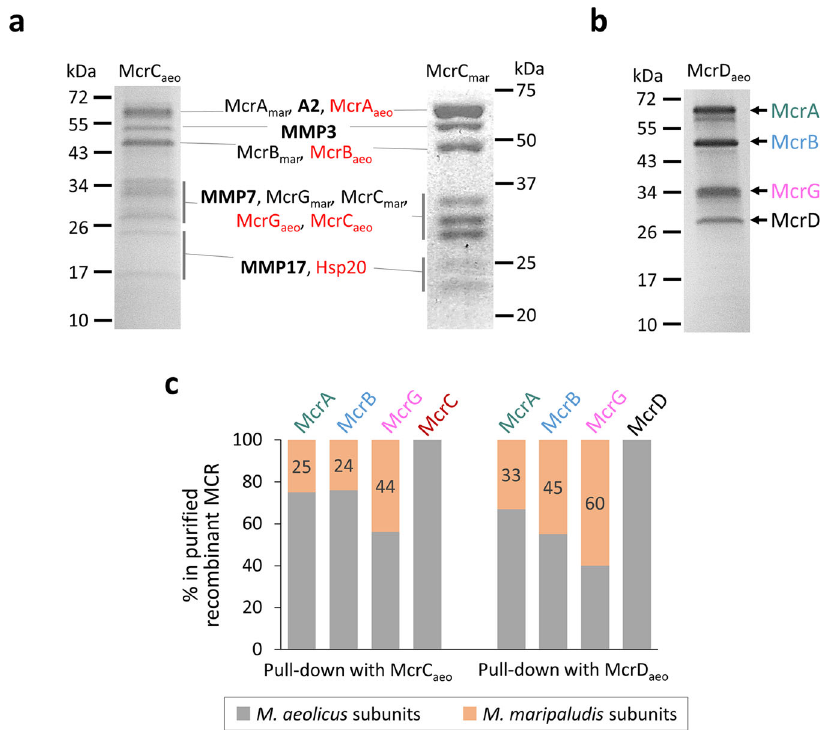
Fig. 5 Pull-down analyses of accessory proteins McrC and McrD. a The McrC aeo construct had the full M. aeolicus mcrBDCGA operon with the Flag-Strep 2 tag added to the N-terminal of McrC. The McrC mar construct contained only the M. maripaludis mcrC with an N-terminal Flag-Strep 2 tag. Proteins co- puri fi ed with McrC aeo and McrC mar were separated by SDS-PAGE and identi fi ed by MALDI-TOF MS. Proteins only puri fi ed with McrC aeo are labeled in red. Besides MCR subunits, the co-puri fi ed proteins (in bold) include M. maripaludis A2 protein (locus tag Mmp_0620), MMP3 (methanogenesis marker protein 3, locus tag Mmp_0154), MMP7 (methanogenesis marker protein 7, locus tag Mmp_0421), MMP17 (methanogenesis marker protein 17, locus tag Mmp_0656), and heat shock protein Hsp20 (locus tag Mmp_0684). b The McrD aeo construct had the full M. aeolicus mcrBDCGA operon with the Flag- Strep 2 tag added to the N-terminal of McrD. Proteins co-puri fi ed with McrD aeo were separated by SDS-PAGE and identi fi ed by MALDI-TOF MS. c The relative abundance of M. aeolicus (in gray) vs. host M. maripaludis (in orange) MCR in each subunit of the puri fi ed complexes determined by LC-MS/MS. The percentages of M. maripaludis protein in total protein of each subunit are